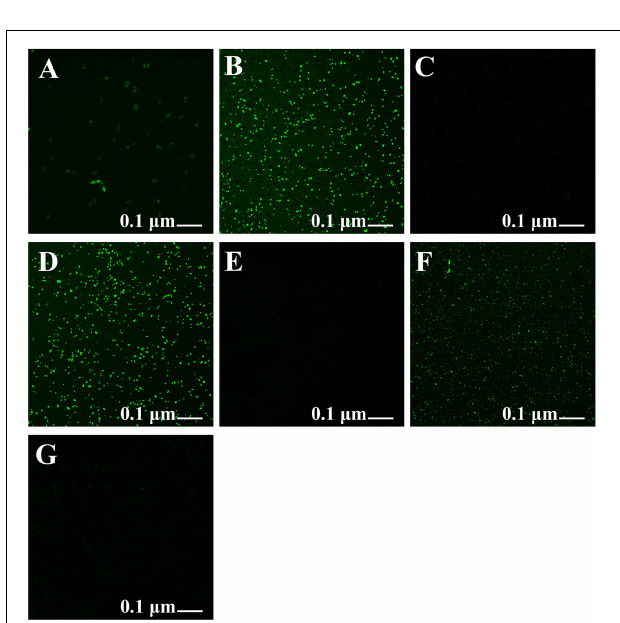
FIGURE 7 | Formation of reactive oxygen species in Xoo strain GZ 0006 cells after 4 h incubation period with (A) Double distilled water, (B) ZnO nanoparticles, (C) Rotenone before ZnO nanoparticles, (D) MgO nanoparticles, (E) Rotenone before MgO nanoparticles, (F) MnO 2 nanoparticles, (G) Rotenone before MnO 2 nanoparticles